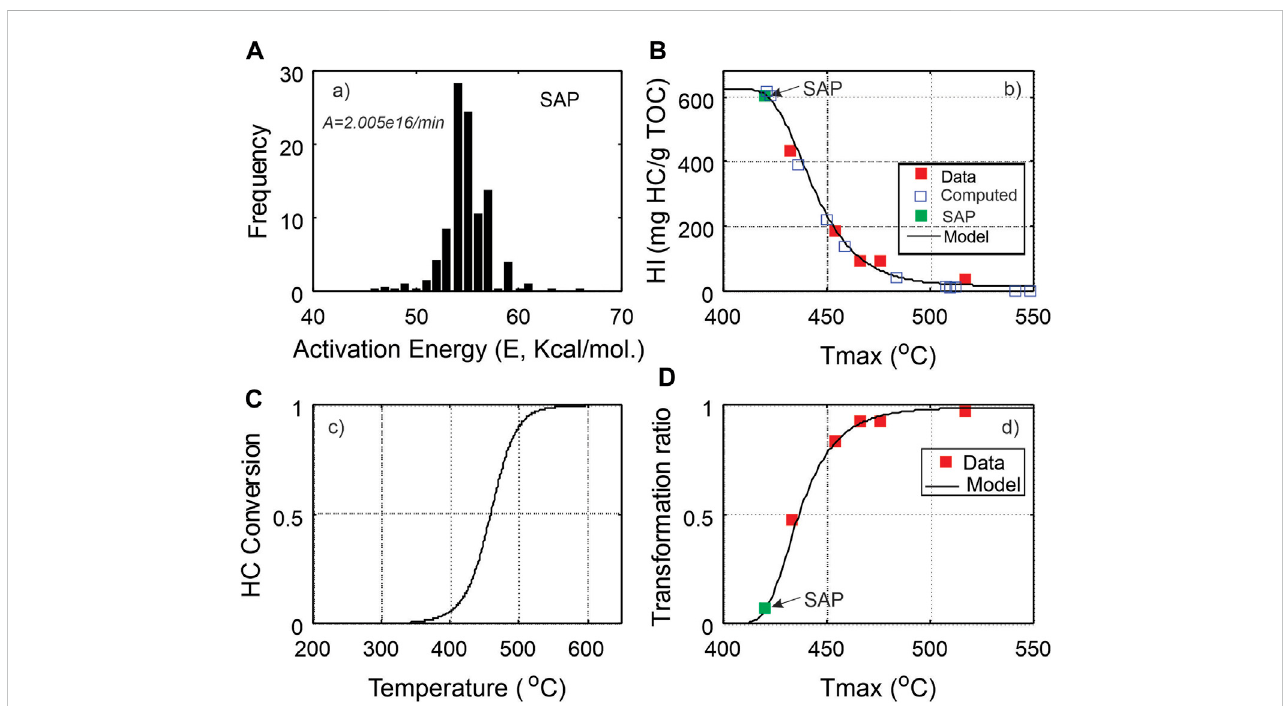
FIGURE 5 Comparison of kerogen conversion models from chemical reaction kinetic model and data-driven model. (A) Estimated kinetic parameters from the core sample SAP in Dieckmann et al. (2004) was used as immature source rock for hydrocarbon generation model; (B) Tmax-HI plot of data and computed Tmax-HIdatapairsusingaforwardmodelling(Chenetal.,2017b); (C) ComputedkerogenconversionrateusingkineticparametersinDieckmannetal.(2004); (D) Constructed empirical model of kerogen transformation ratio from data in Figure